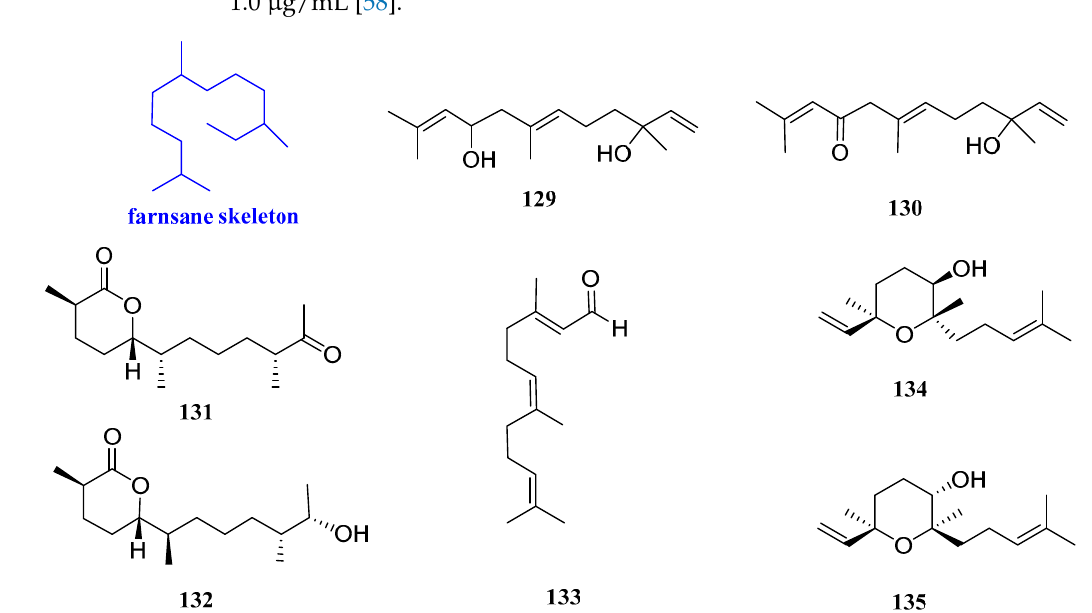
Figure 11. Structures of farnesane-type sesquiterpenoids 129 – 135 .